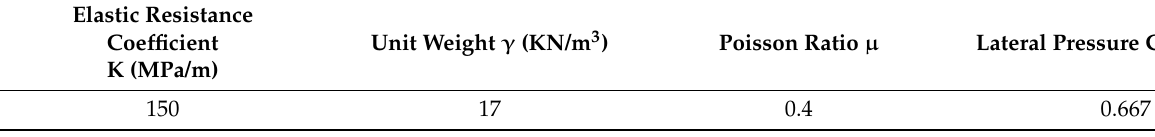
Table 1. Mechanical parameters of surrounding rock [30].